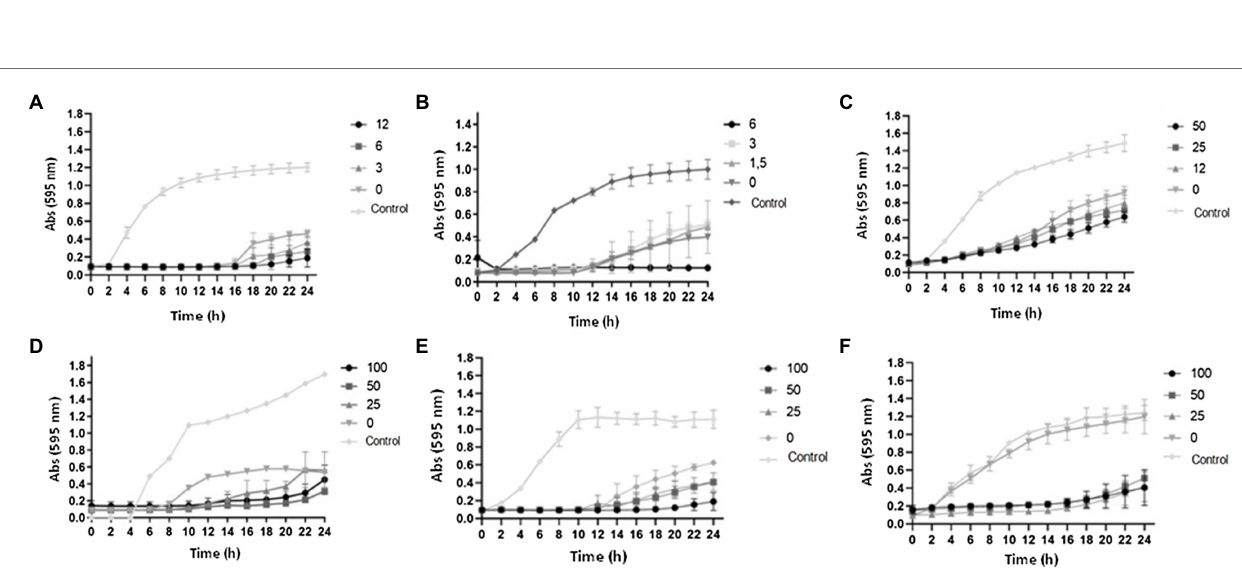
FIGURE 6 | Effect of phenolic compounds on biofilm formation by Serratia marcescens MG1 expressed as percentage of production, when compared to the control (100%). Curcumin (A) ; capsaicin (B) ; resveratrol (C) ; and control = biofilm formation in LB broth + DMSO (1%). Means followed by different letters differ among themselves by Tukey’s test ( p < 0.05).